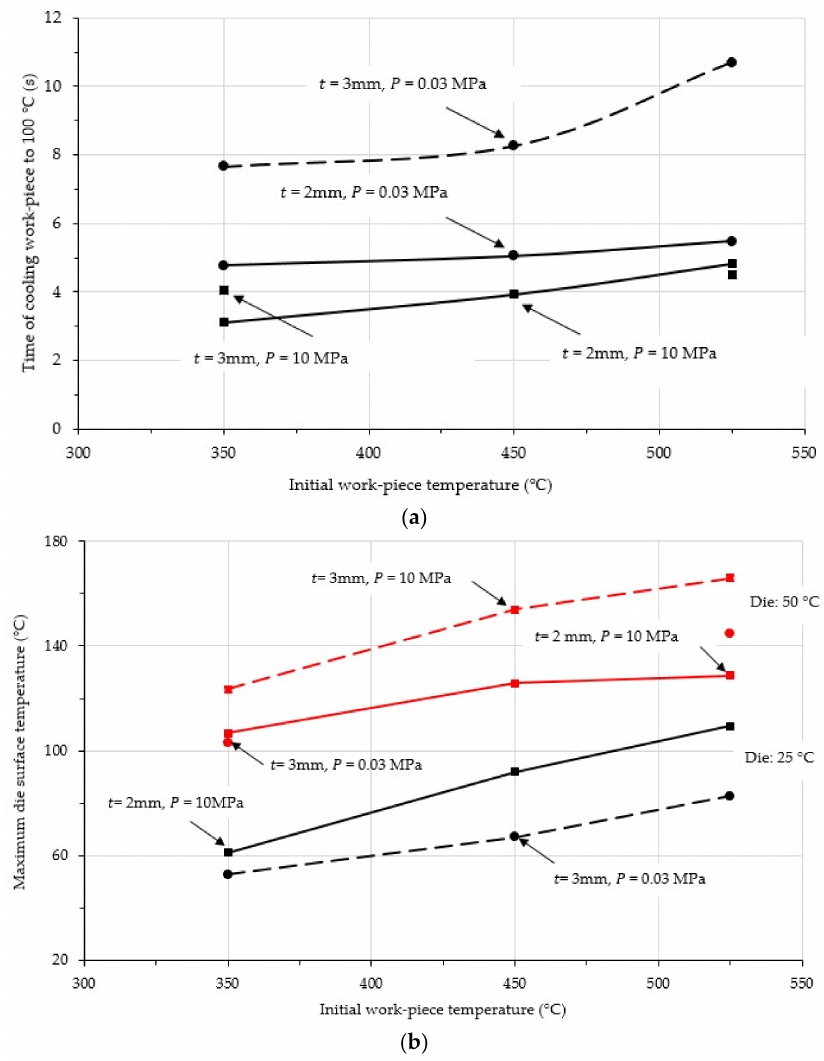
Figure 10. Effects of work-piece thickness on the in-die quenching performance, where the solid lines represent the 2 mm work-piece and the dash lines represent the 3 mm work-piece: ( a ) Time of cooling work-piece to 100 ◦ C and ( b ) calculated maximum die surface